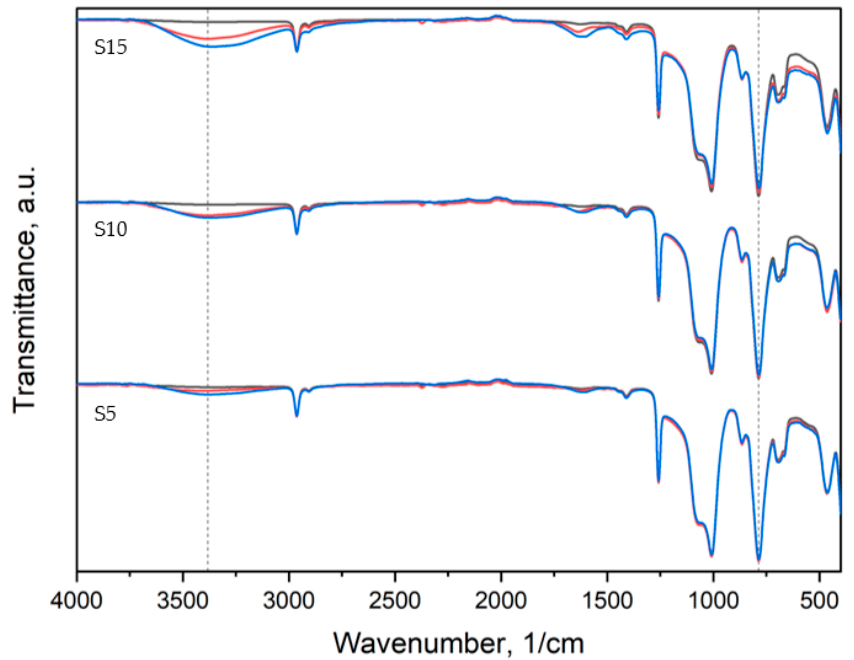
Figure 13. IR spectra of sage composites: black—before aging, red—2 days of aging, blue—60 days of aging.